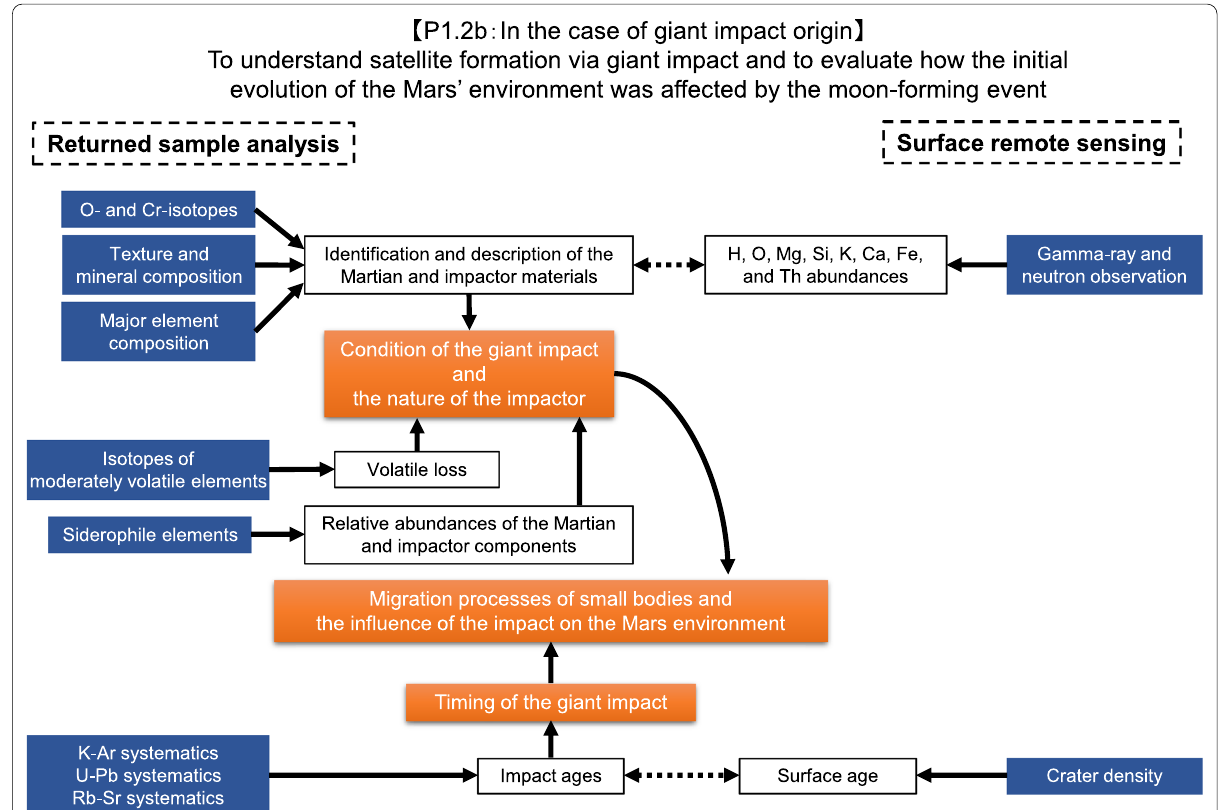
Fig. 3 Flowchart of sample analyses together with remote sensing observations to characterize the Phobos building blocks in the case of the giant impact origin (objective 1.2b in Table 1)